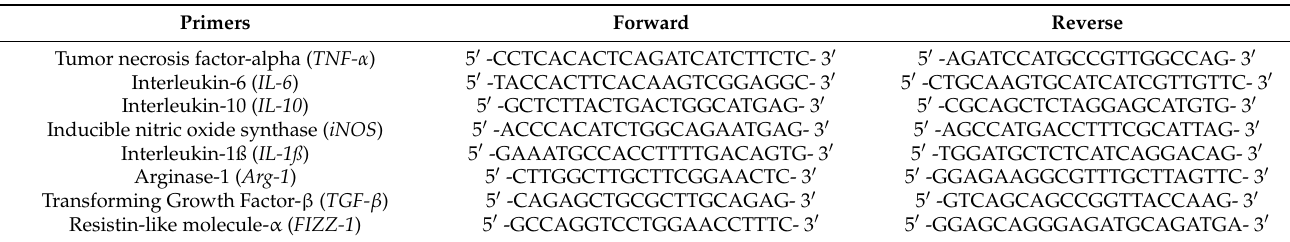
Table 1. List of primers used in the